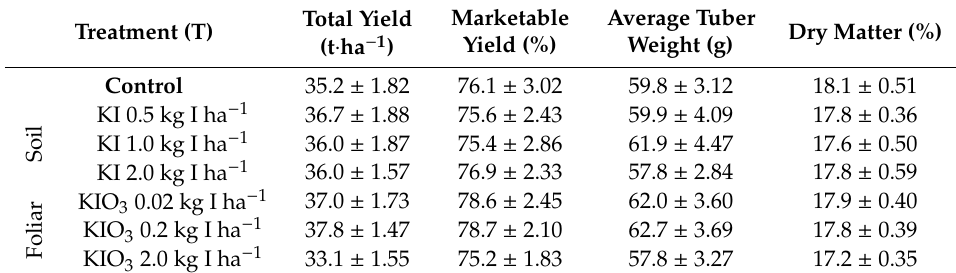
Table5. Totalandmarketableyield, averagetuberweightanddrymattercontentinpotatotubers–means for three-years of the study; values ± standard error ( n =